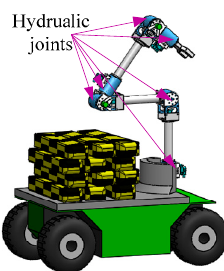
Figure 1. The schematic diagram of the multi-joint vehicle manipulator.